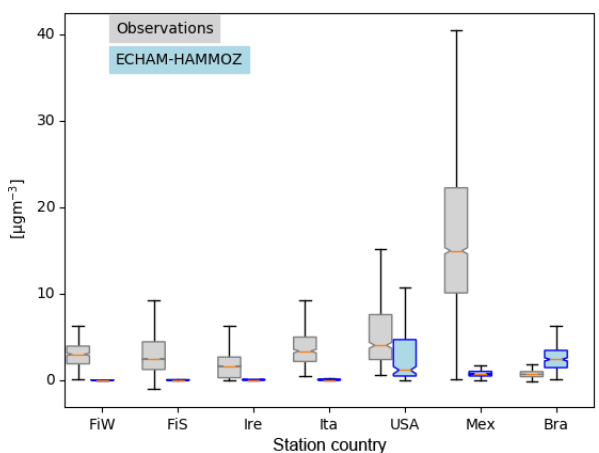
Figure 8. Box plots showing the variability of concentrations mea- sured and the corresponding instantaneous values from ECHAM– HAMMOZ. Countries of measurement campaigns are given. The abbreviations refer to the following. FiW: Helsinki, Finland (Win- ter), FiS: Helsinki, Finland (Spring), Ire: Mace Head, Ireland, Ita: Po Valley, Italy, USA: Houston Texas, USA, Mex: Mexico City, Mexico, Bra: Manaus, Brazil. The model time resolution is 3h; all values given from the observations are included, meaning that they have a higher time